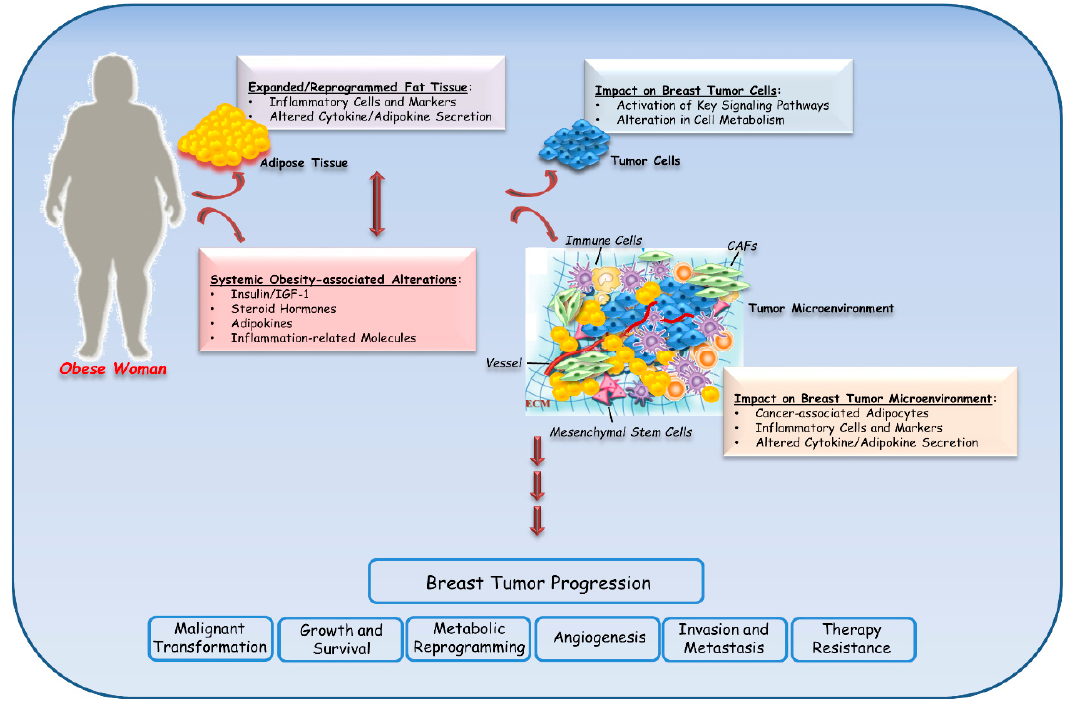
Figure 1. Mechanisms linking obesity with breast cancer. In obese women, excess adiposity is associated with key local and systemic changes, such as altered secretion of cytokines, adipokines, growth factors, and inflammatory molecules. The complex interplay among all of these alterations may contribute to breast cancer progression by both directly impacting the phenotype of cancer epithelial cells and indirectly affecting the behavior of the tumor microenvironment. IGF: insulin-like growth factor; CAFs: Cancer-associated fibroblasts; ECM: Extracellular